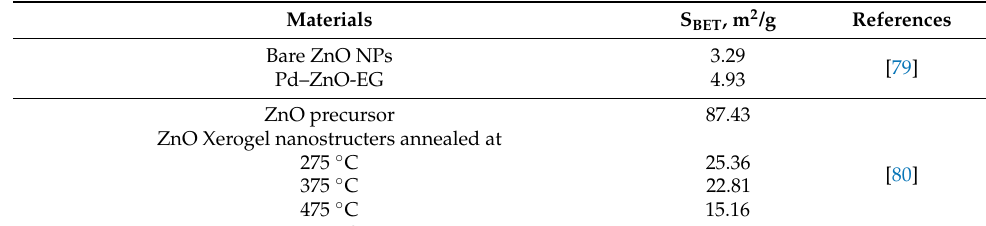
Table 4. Comparison of the obtained SBET of synthesized Carbopol/ZnO hybrid nanoparticles gel with those for bare ZnO NPs and the other hybrid systems in the